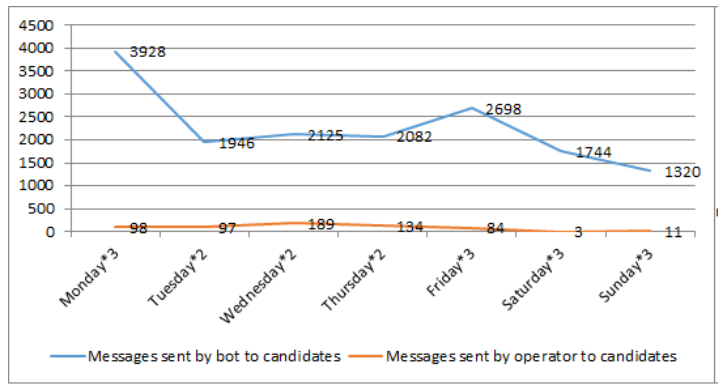
Figure 13. Messages sent by bot and operator to